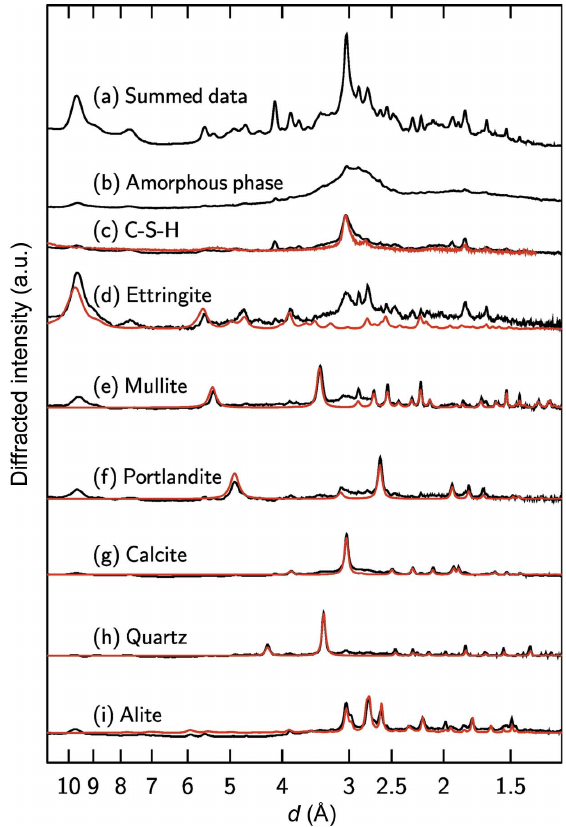
Figure 2 Plots (black lines) representing the experimental XRD patterns ( a ) obtained when summing the whole volume, ( b ) of an amorphous phase (see text for explanation), ( c ) of C-S-H, ( d ) ettringite, ( e ) mullite, ( f ) portlandite, ( g ) calcite and ( h ) quartz. Also included is ( i ) the experimental pattern of alite, which was detected in the in situ hydration experiment (see text). The red overlays on the experimental XRD patterns are the corresponding experimental reference pattern or calculated but not refined XRD pattern, and were reproduced according to the published structural models (Angel et al. , 1991; de la Torre et al. , 2008; Graf, 1961; Henderson & Gutowsky, 1962; Levien et al. , 1980; Moore & Taylor,